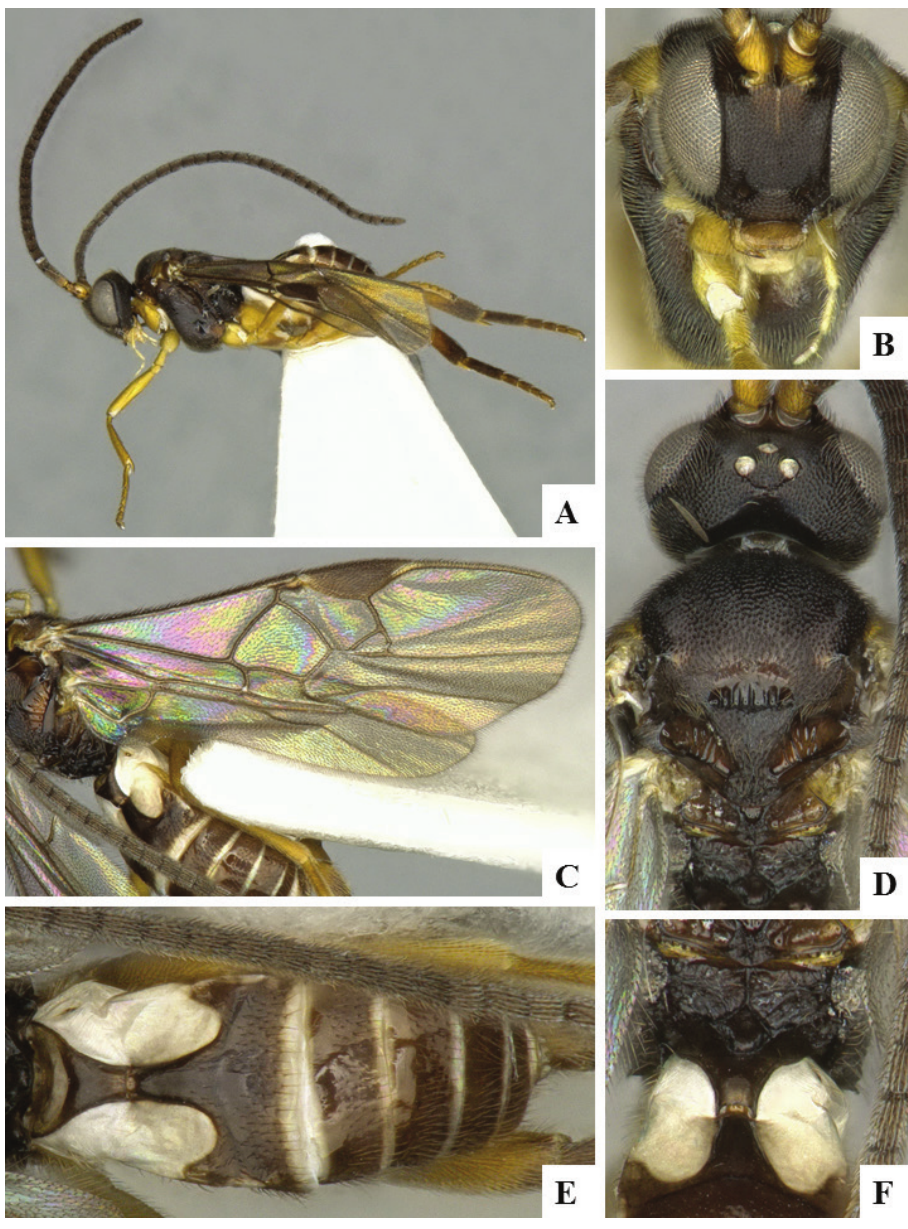
Figure 36. Tobleronius orientalis male holotype. A Habitus B Head frontal C Fore wing and hind wing D Head and mesosoma, dorsal E Metasoma dorsal F